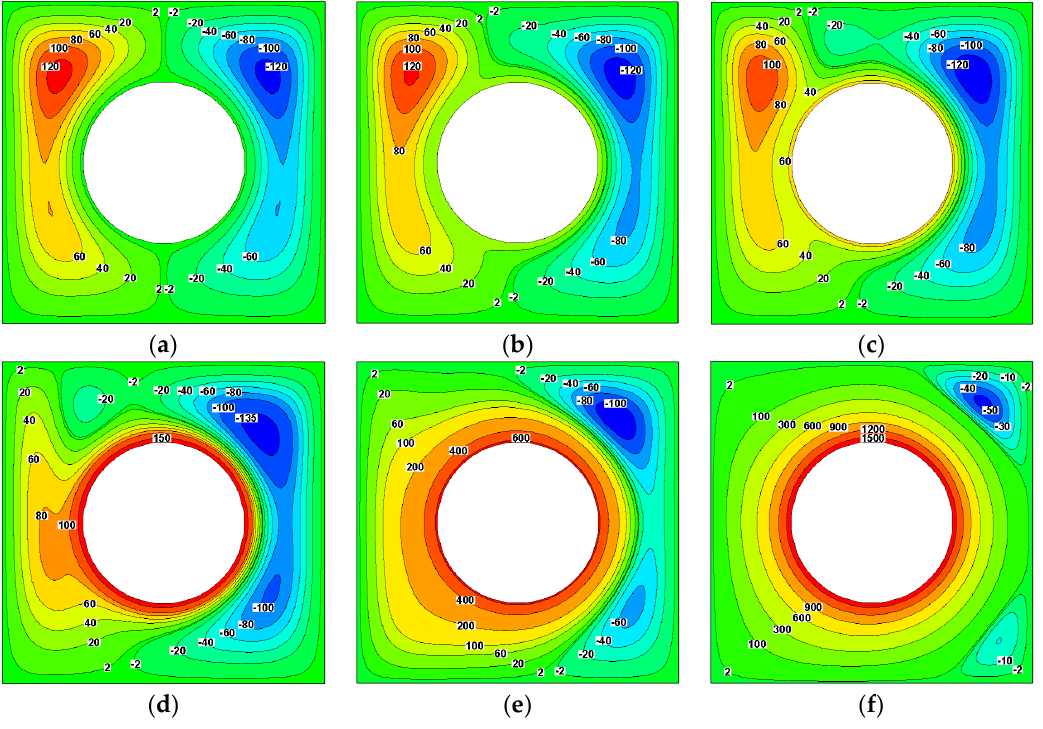
Figure 4. ( a ) N = 0, ( b ) N = 10, ( c ) N = 20, ( d ) N = 50, ( e ) N = 100, ( f ) N = 200. Contours of stream function at λ = 0.5, Ha = 0 and Ra = 10 6 .